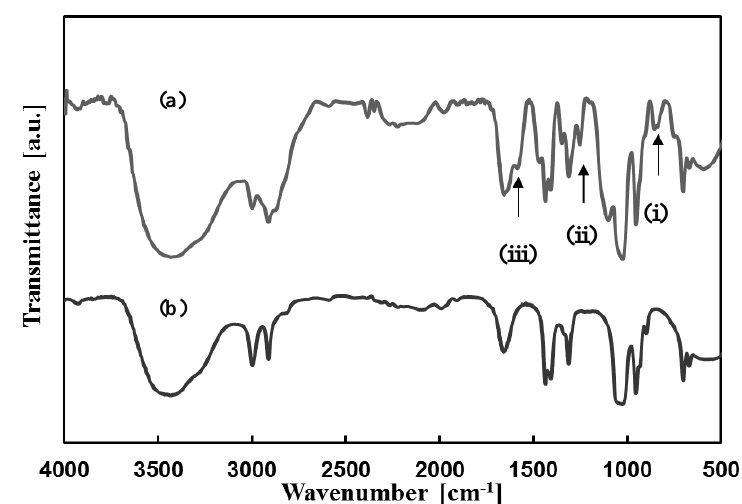
Figure 1. FT-IR spectra of polyethyleneimine (PEI)-polyethylene glycol diglycidyl ether (PEGDE)400 reaction system of Case 1: ( a ) before reaction and ( b ) after reaction at 90 ◦ C, solvent: dimethyl sulfoxide (DMSO), monomer concentration: 30